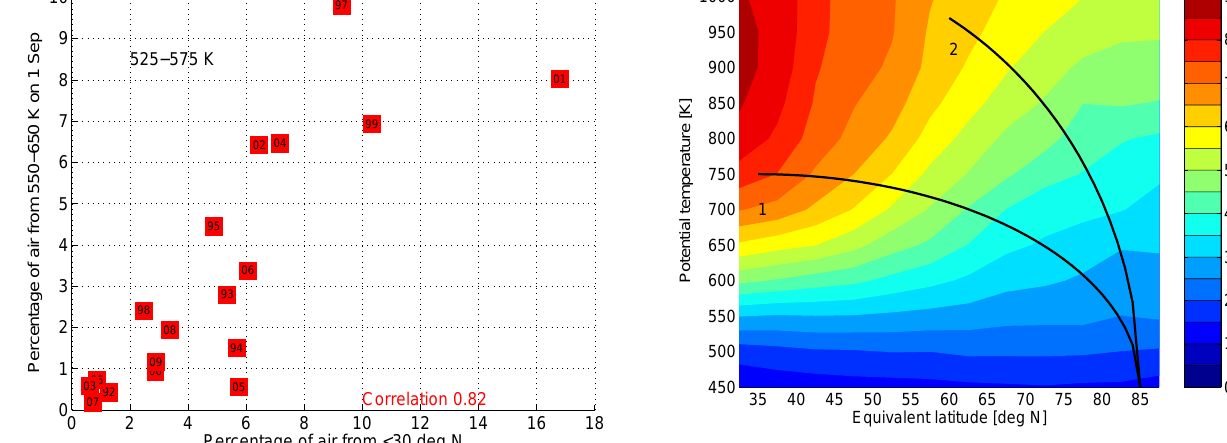
Fig. 11. Scatter plot of the vortex mean of two origin tracers in early winter at 525–575K. Each marker gives the values of the two trac- ers in the particular year shown inside the marker. The tracer on the horizontal axis is the fraction of air originating from equivalent lati- tudes south of 30 ◦ N on 1 September. The tracer on the vertical axis is the fraction of air originating from the initial potential tempera- ture interval 550–650K on 1 September (i.e. with a maximum of 125K Lagrangian subsidence).